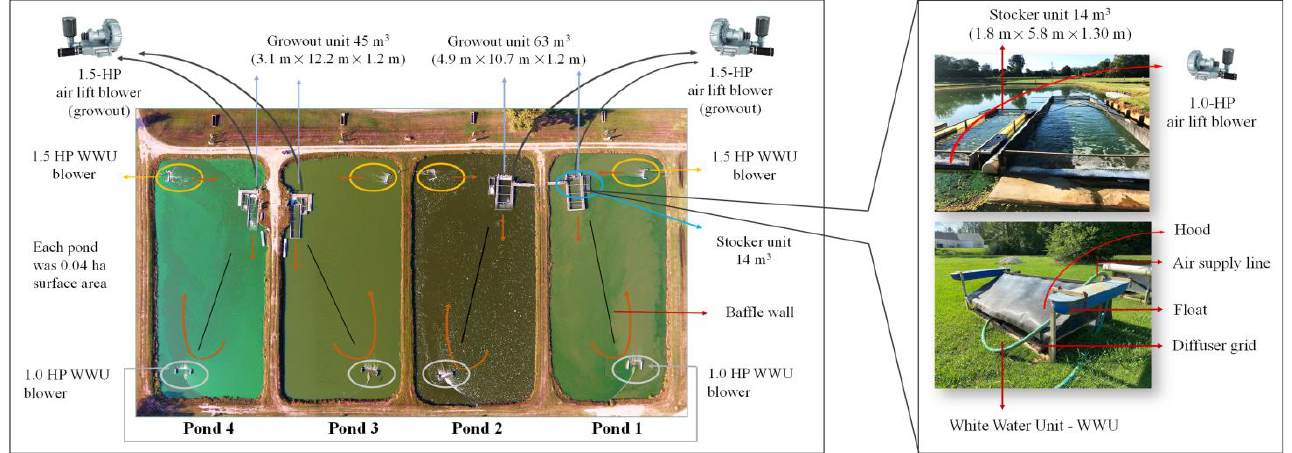
Figure 1. Aerial view of the four 0.4 ha ponds including the four growout and four stocker IPRS units per pond.